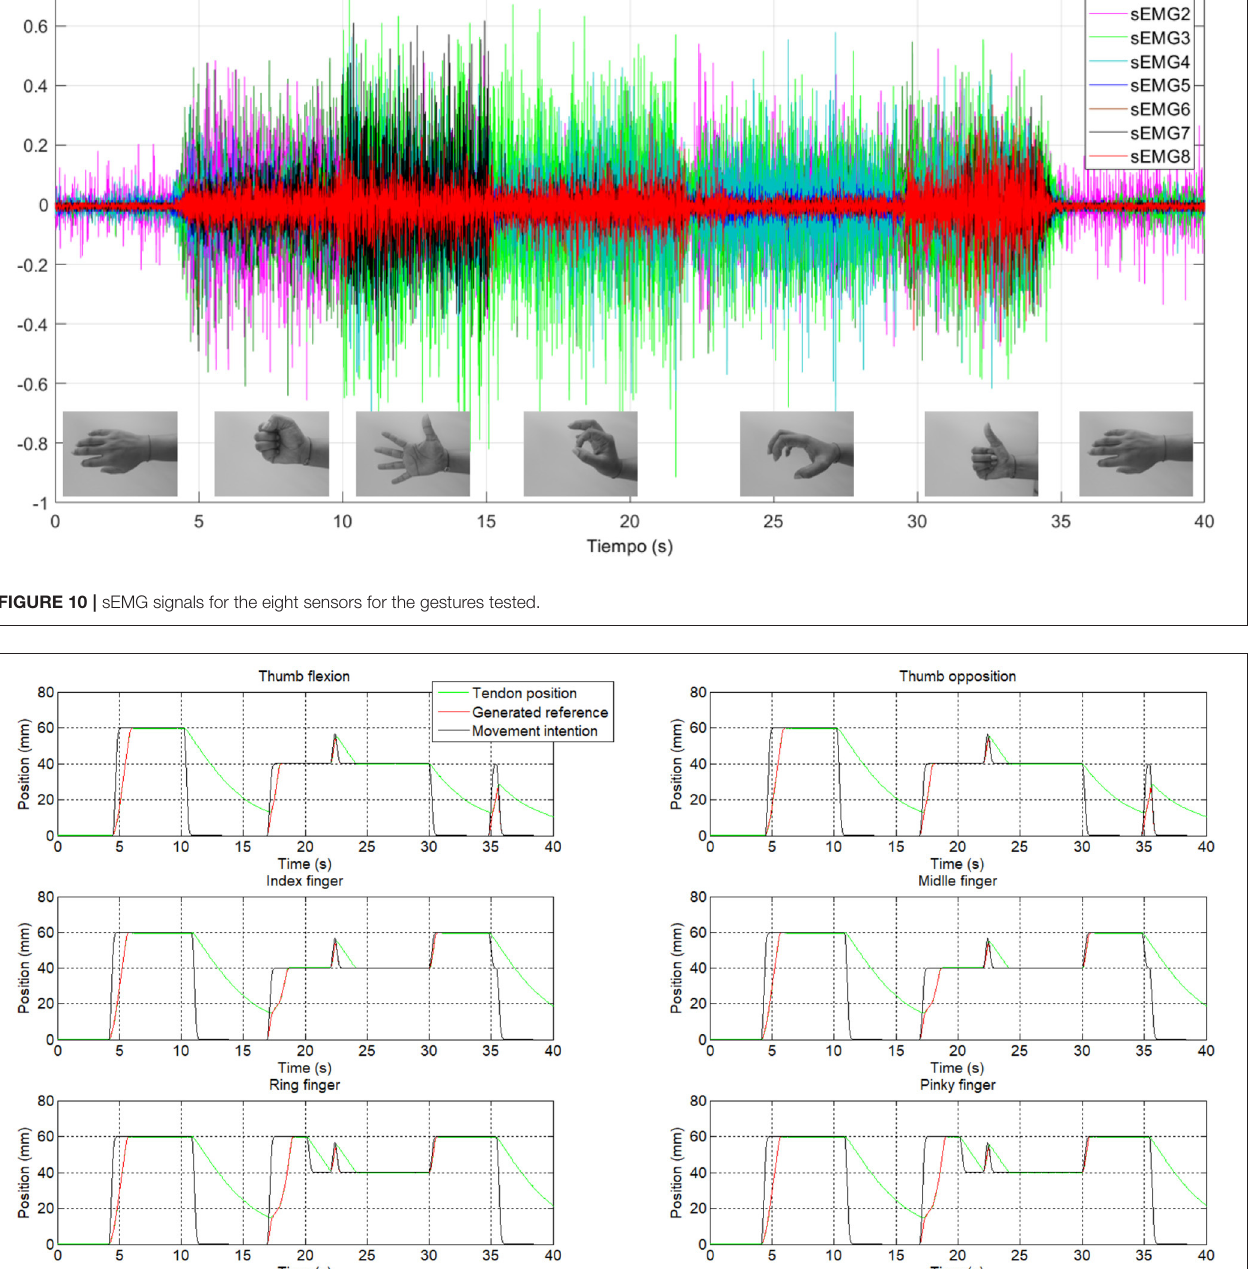
and a maximum of 83.9% using only one Myo armband. Accordingly, to these previous studies, the channel number influences the classifier accuracy; more information presents better results. Also, the deep learning algorithms present good results, but the necessary time to train these algorithms was not